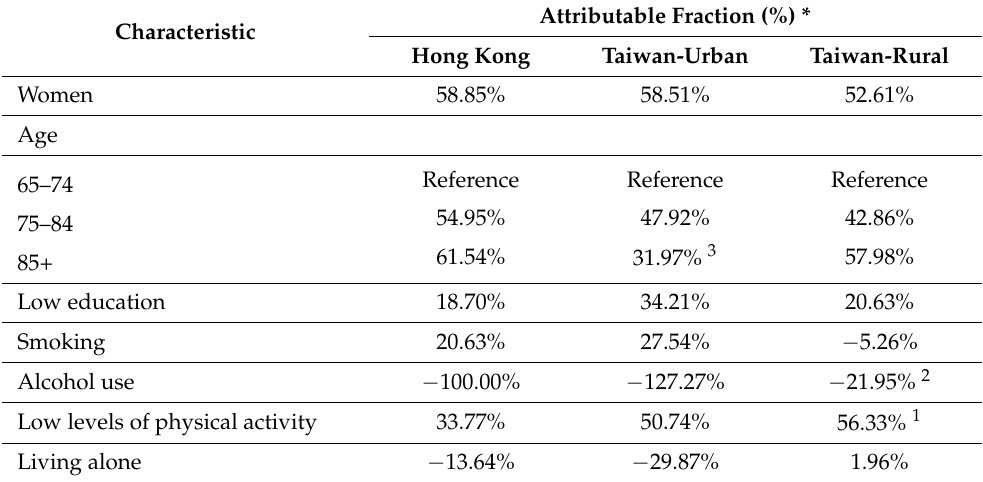
Table 5. Attributable fraction for frailty in Hong Kong, Taiwan-urban and Taiwan-rural (both sexes).